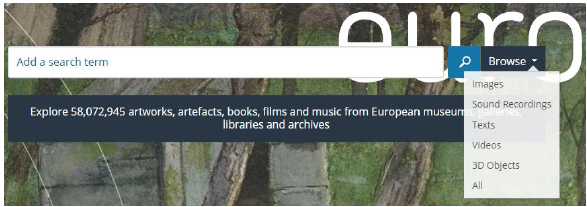
Figure 1. Search bar of europeana.de showing additional filter